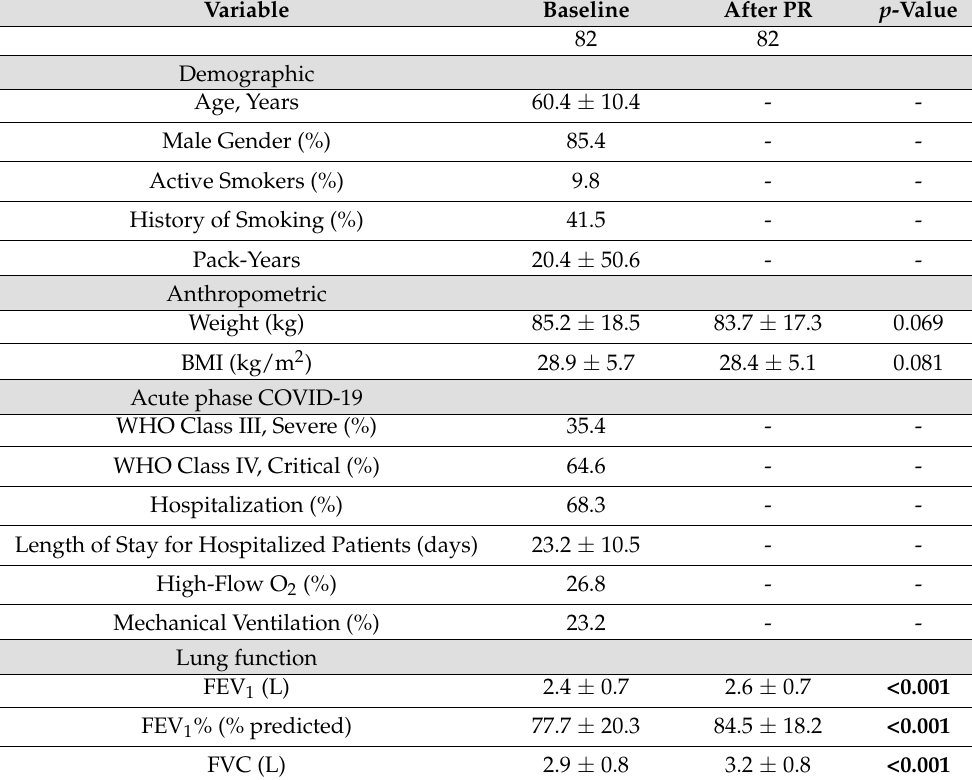
Table 1. Baseline characteristics of convalescent COVID-19 patients and changes in body composition, pulmonary function tests, laboratory parameters and other outcome measures after pulmonary rehabilitation